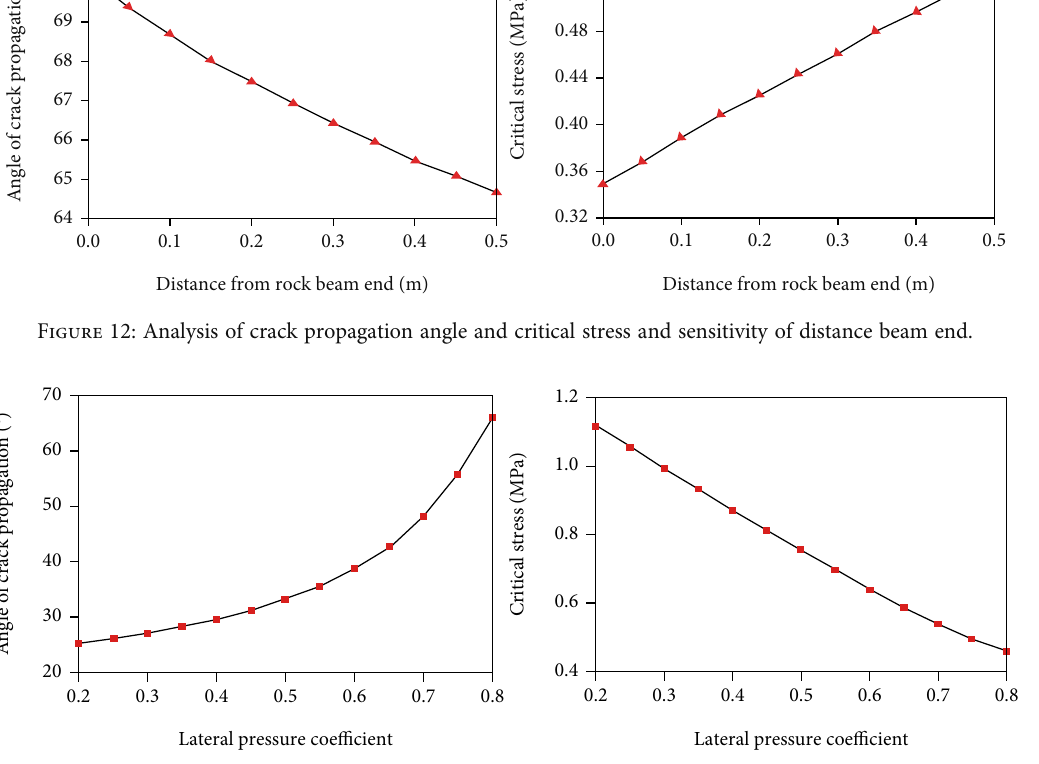
Figure 13: Sensitivity analysis of crack propagation angle and critical stress and lateral pressure coe ffi